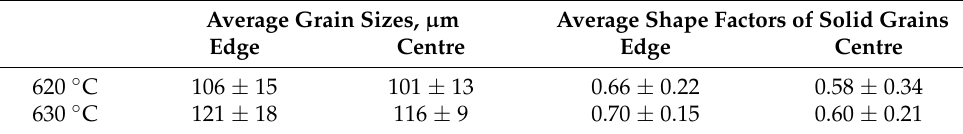
Figure 4. Semi-solid microstructure of 7075 aluminium alloy for 50 min at: ( a ) 620 °C located at the edge of billets; ( b ) 620 °C located in the centre of billets; ( c ) 630 °C located at the edge of billets; ( d ) 630 °C located in the centre of billets. Table 3. Statistical results of microstructure of semi-solid 7075 aluminium alloys.